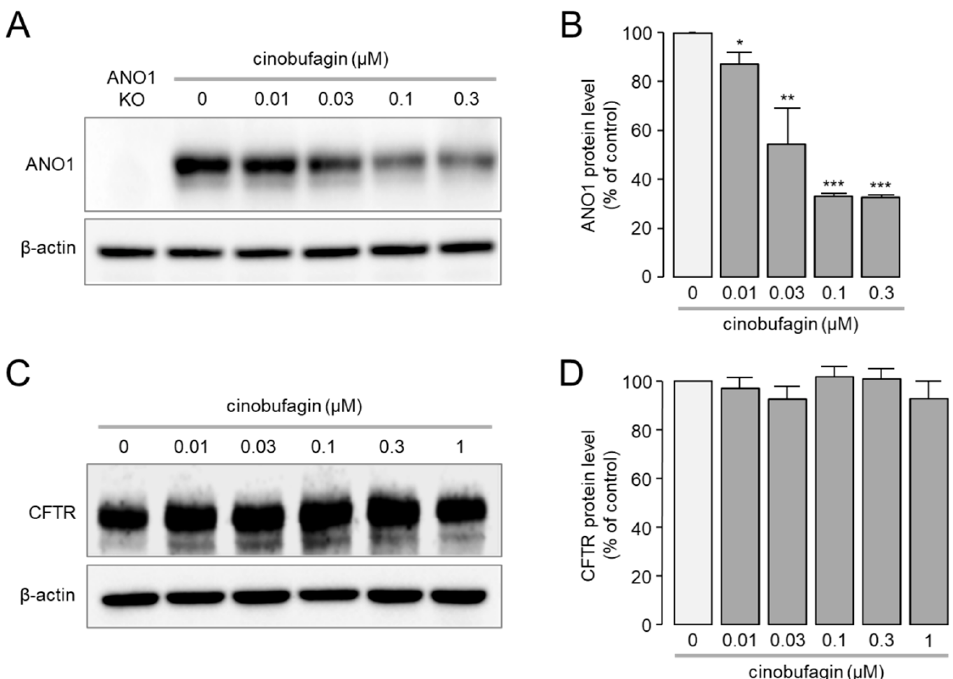
Figure 2. Effect of cinobufagin on protein expression level of ANO1 and CFTR. ( A ) Representative immunoblot analysis of ANO1 in cinobufagin-treated CAL-27 cells. Cinobufagin-treated cells at the indicated concentration for 24 h. CRISPR/Cas9 technique was used to generate CAL-27 ANO1 knockout (KO) cells. ( B ) ANO1 protein intensities were normalized to those of β -actin (mean ± S.D., n = 4). * p < 0.05, ** p < 0.01, *** p < 0.001. ( C ) Representative immunoblot blot analysis of CFTR in cinobufagin-treated FRT cells expressing human CFTR. Cinobufagin-treated cells at the indicated concentration for 24 h. ( D ) CFTR protein intensities were normalized to those of β -actin (mean ± S.D., n = 3).